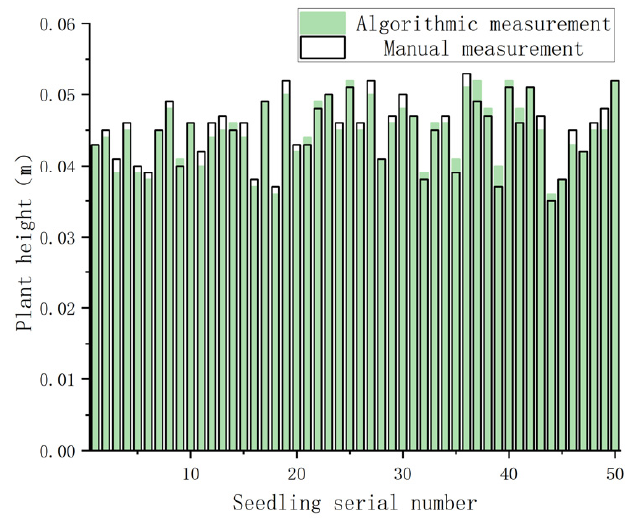
Figure 12. Comparison of manual and algorithmic measurements of the height of the first plug seed- ing.